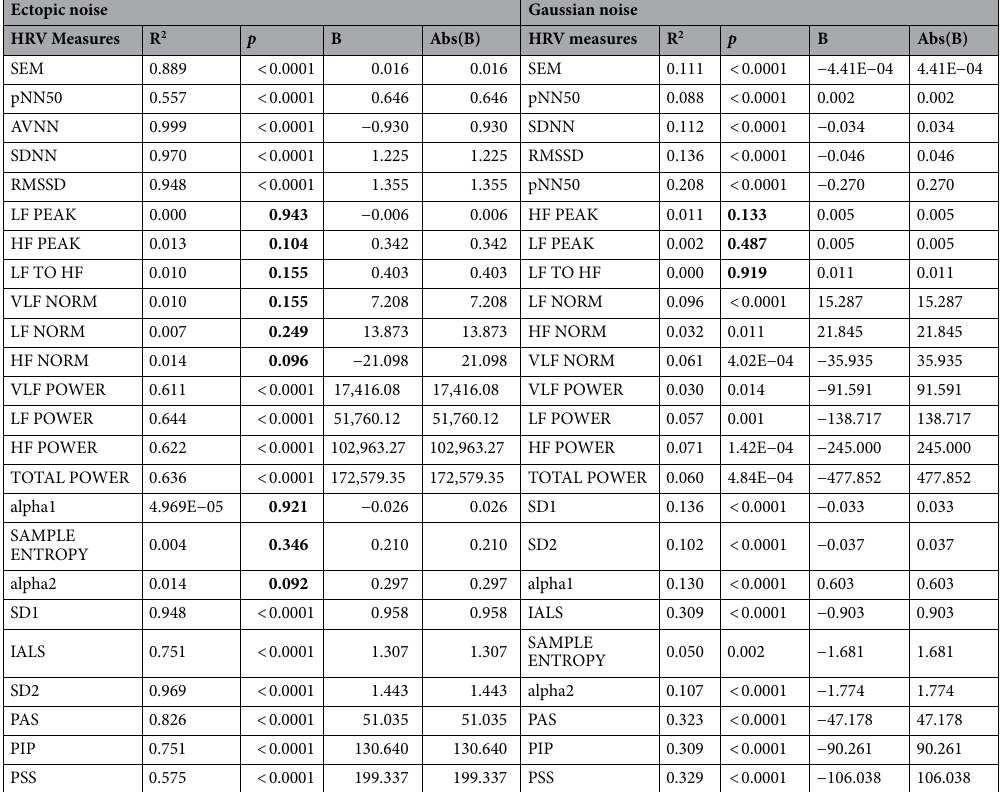
Table 2. HRV measures ranked by absolute value of slope (B) on linear regression grouped by time domain measures, frequency domain measures and non-linear and fragmentation measures. Non-significant values are bold.